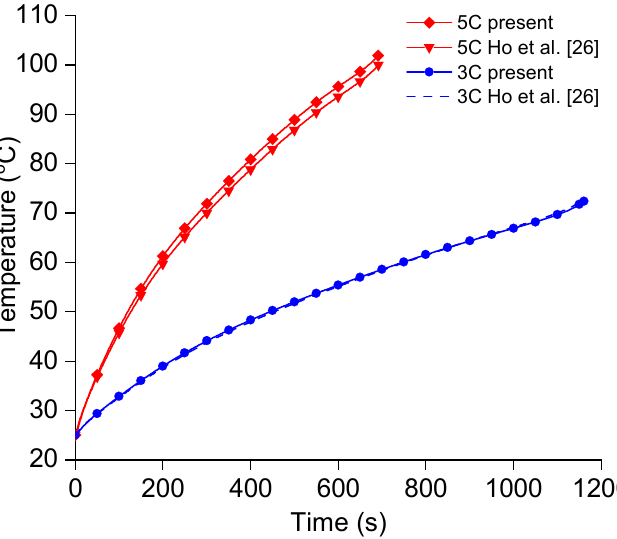
Figure 6. Comparison of temperatures by the NTGK model in this study and by Ho et al. [26].